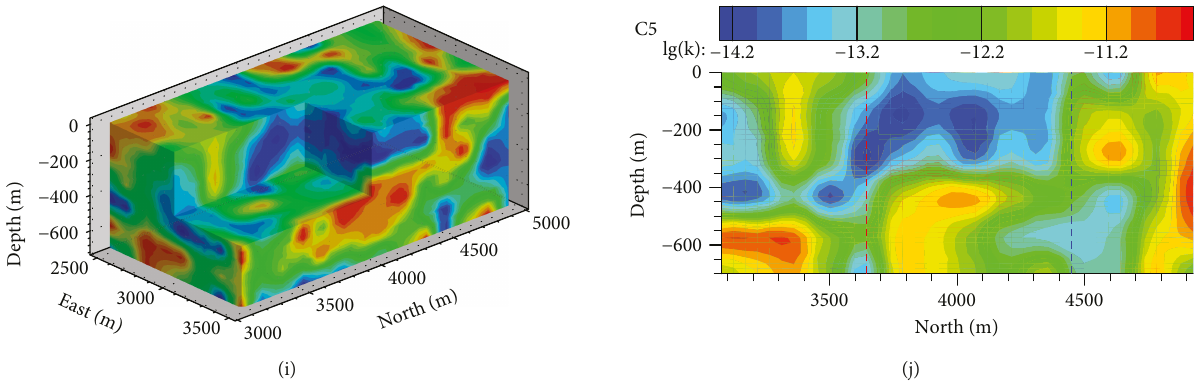
Figure 6: Five hypothetical heterogeneous permeability distributions ((a) C1, (c) C2, (e) C3, (g) C4, and (i) C5) and the corresponding two-dimensional cross sections (b, d, f, h, j) at east 3000 m. Red dashed lines and blue dashed lines indicate the location of production well and injection well,